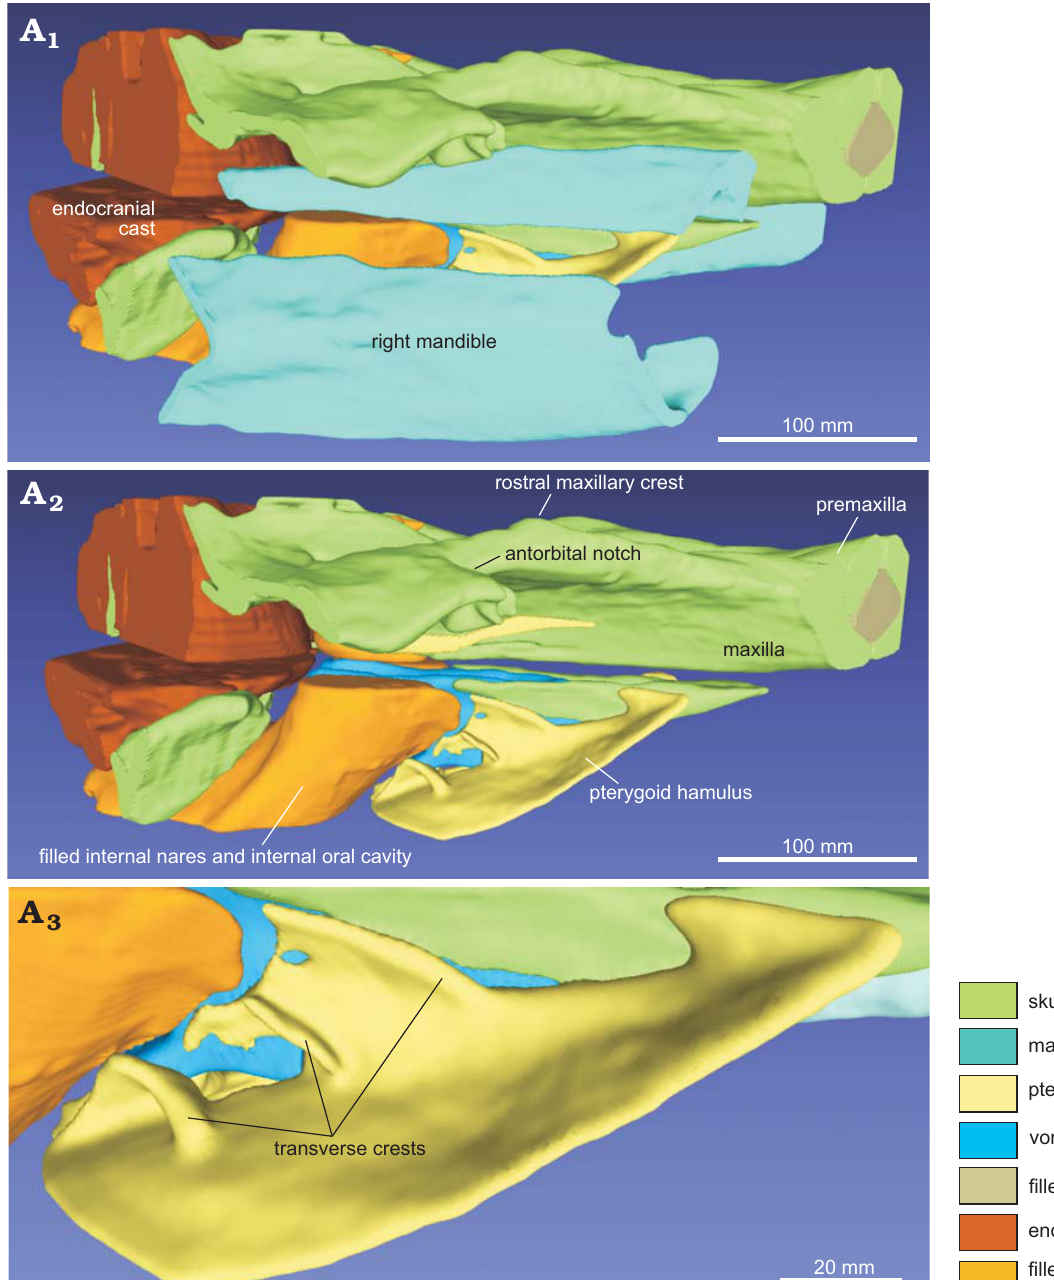
Fig. 6. 3D reconstruction resulting from the CT-scan of the ziphiid cetacean Messapicetus cf. longirostris Bianucci, Landini, and Varola, 1992 skull (MDM-2029) inside two limestone slabs from the Tortonian of Menorca (Balearic Islands, Spain); in right lateral view (A 1 ), right lateral view without the mandibles (A 2 ), detail of the pterygoid hamuli showing the well-preserved transverse crests (A 3